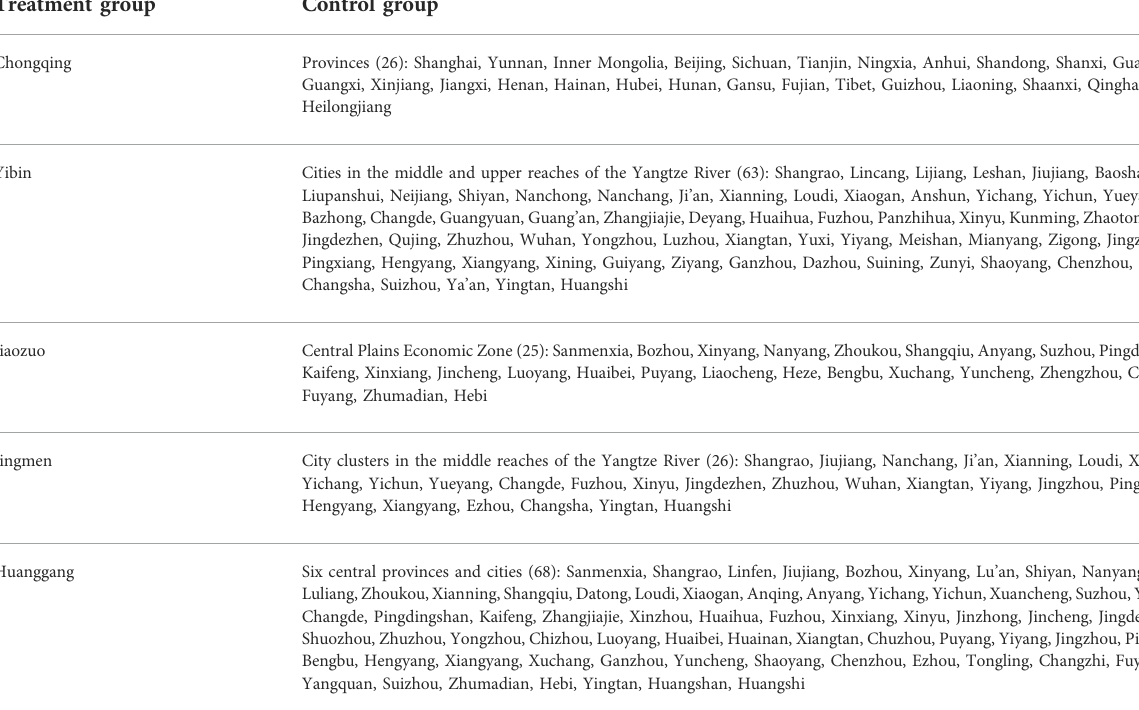
TABLE 3 Treatment group and control group. Treatment group Control